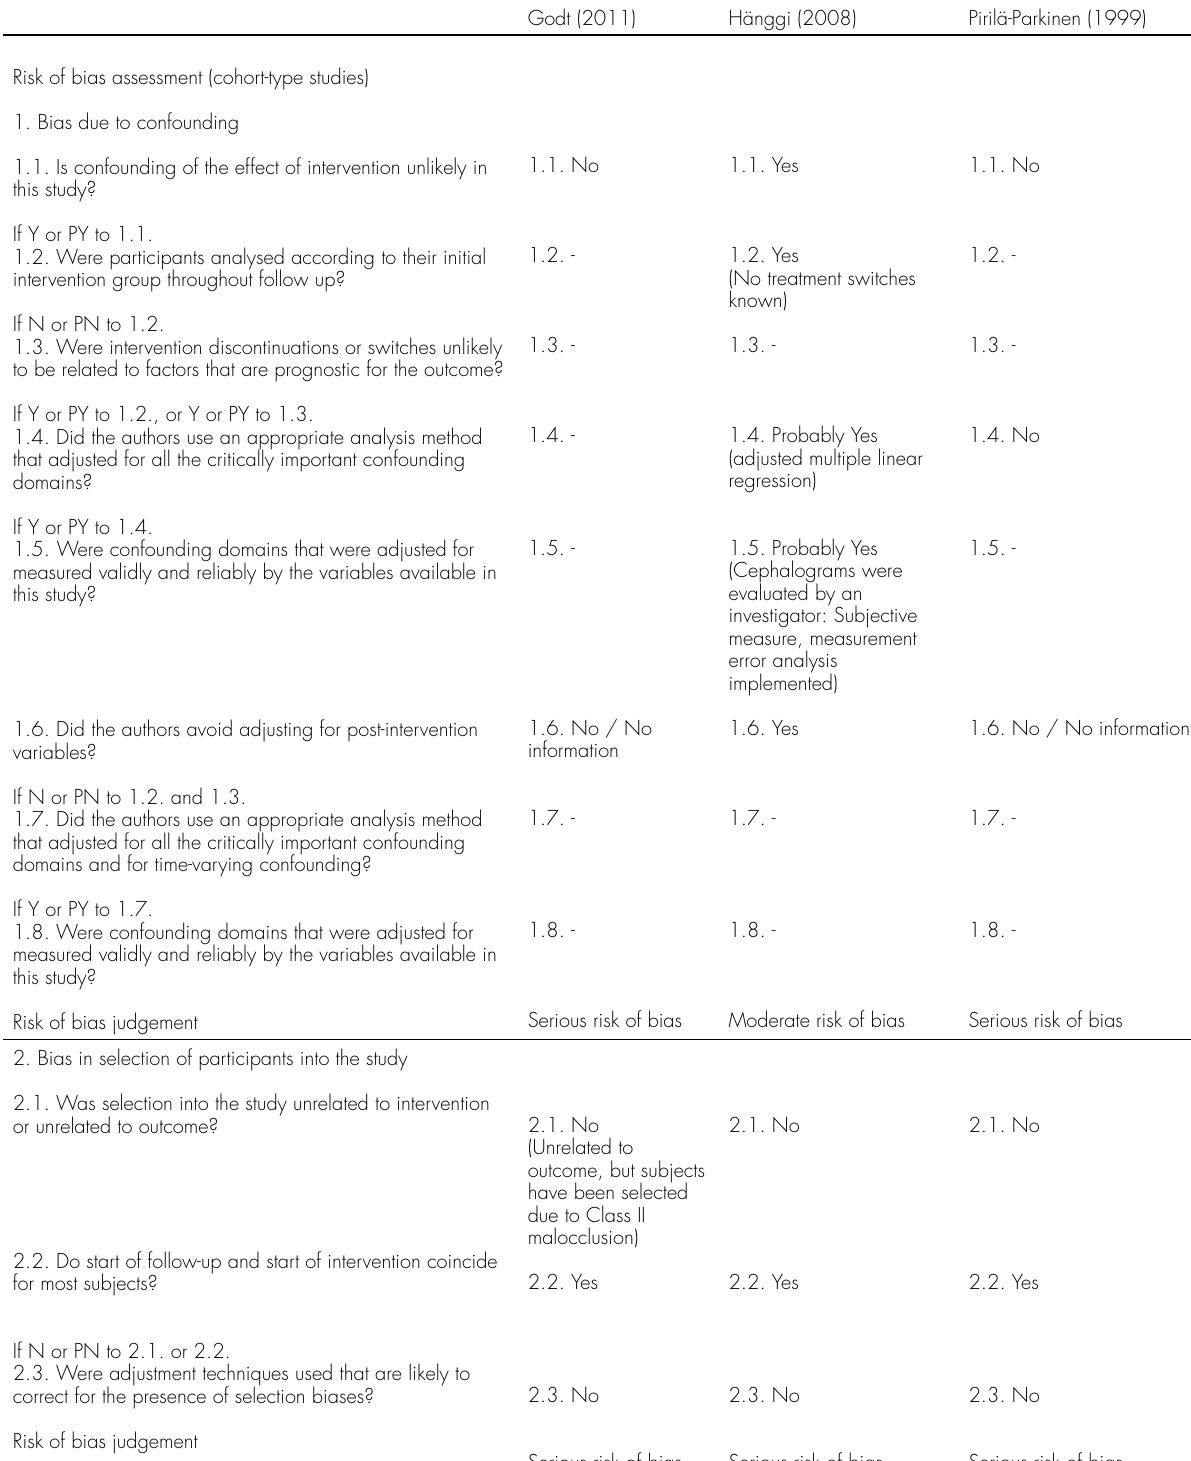
Table III. The ACROBAT-NRSI tool: risk of bias based on signalling questions: for each study/cohort-type